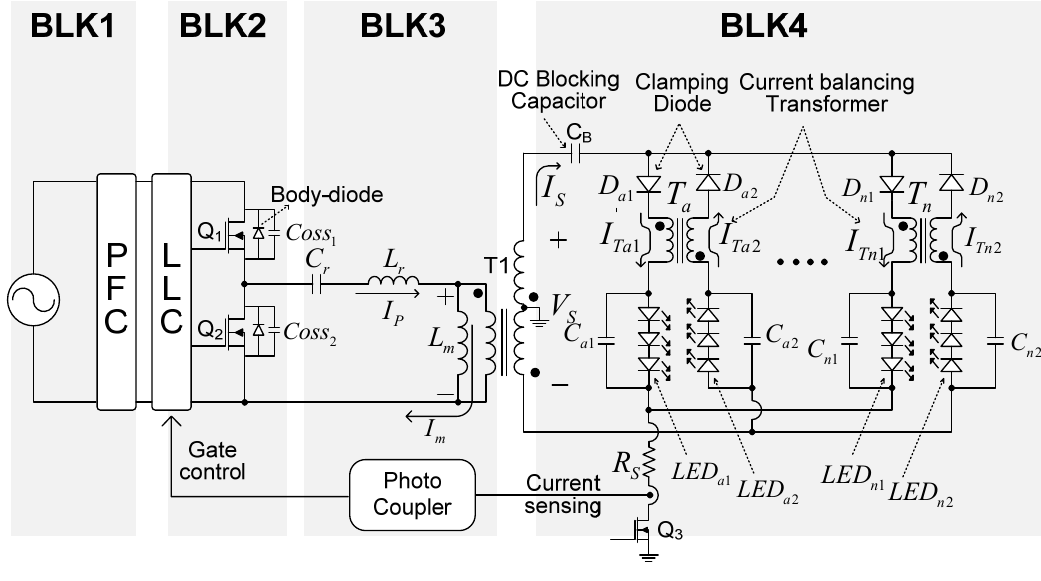
Figure 4. Proposed current balancing